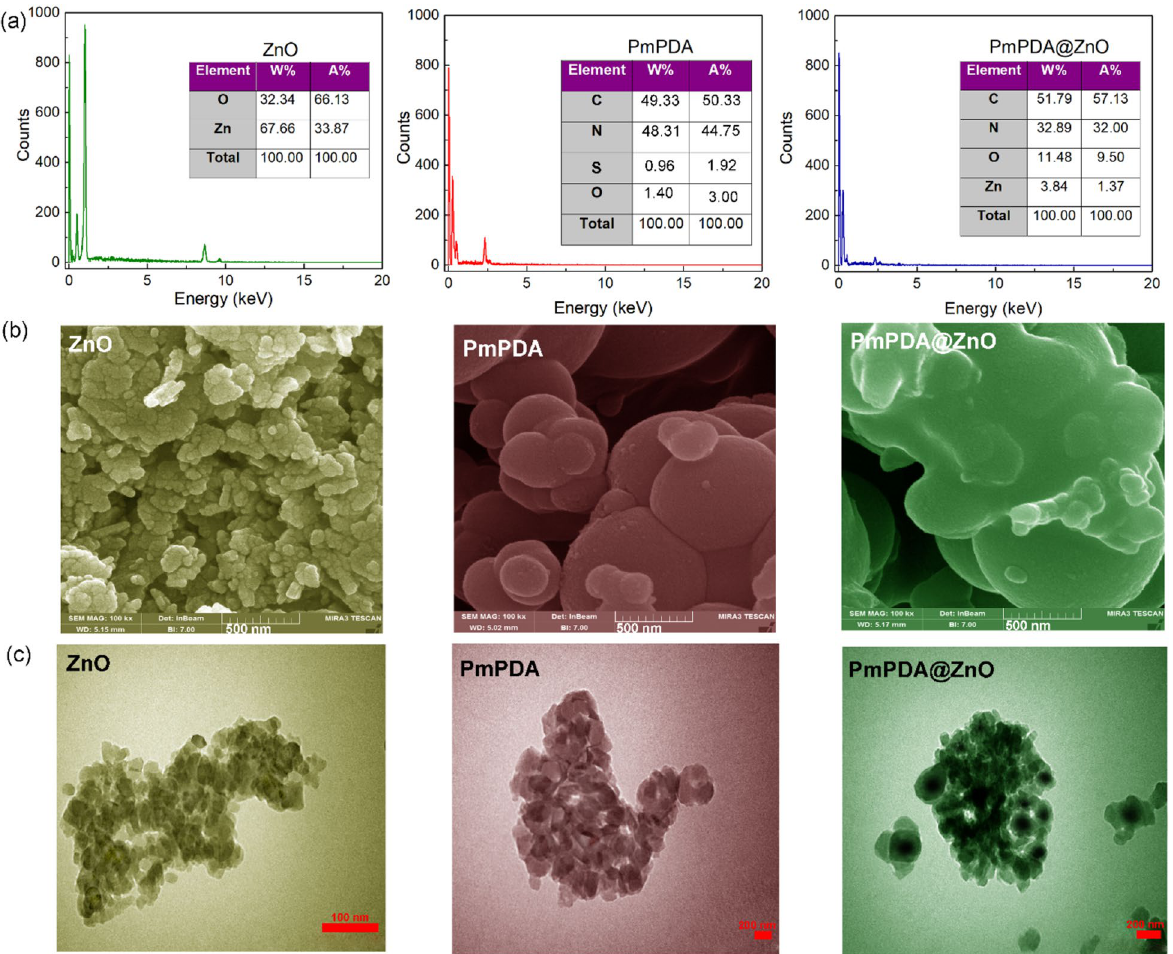
Figure 2. EDX spectra ( a ), FESEM ( b ) and TEM ( c ) images of ZnO, PmPDA, and PmPDA@ZnO.